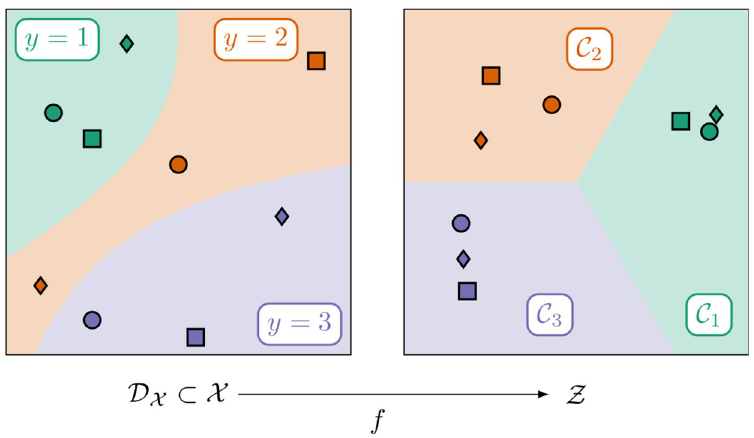
Fig 3. Illustration of the training data transformation. Illustration of the training data transformation f : f x ; ... ; x g ! Z ¼ R 2 from (14) for an exemplary ternary classification problem ( n = 3) with a two-dimensional 1 D feature space X � R 2 . The colored regions on the left illustrate the true regions of the three classes with their respective labels, whereas the points denote the (noiselessly) sampled training datapoints x 1 , ... , x . We sample three points from D each class (i. e., D = 9) and use different symbols ( � , □ and ♢ ) to uniquely identify each point. As the distance metric d underlying f , we choose the Euclidean distance. The other hyperparameters are chosen as α ≔ 0, β ≔ 1 and k α , k β ≔ 1, respectively. The figure shows that the farther a training datapoint x i (for i 2 {1, ... , D }) is away from its nearest foreign-class neighbor, the clearer is the membership of f ( x ) to the respective cone segment C . i y ð x i Þ